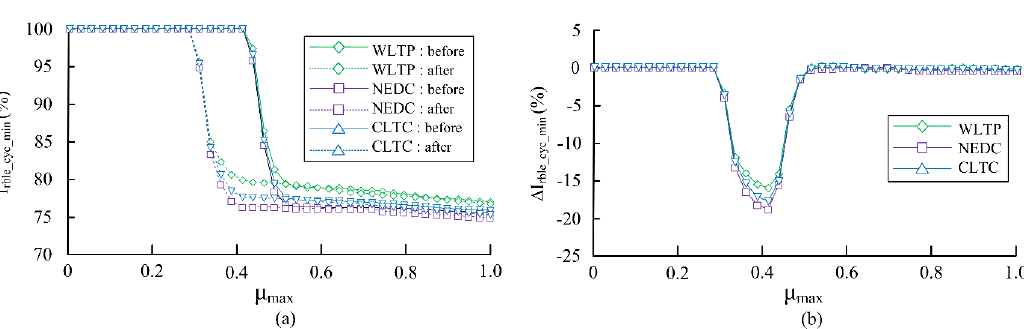
Figure 16. Optimization results in three driving cycles before and after optimization: ( a ) I bclr_cyc and ( b ) ∆ I bclr_cyc . The optimization calculation results are shown in Table 5. Table 5. Results of optimization. Item